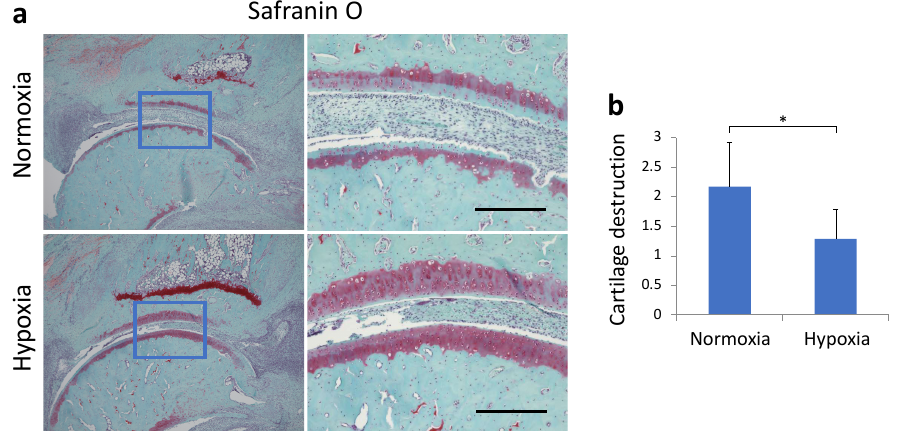
Figure 5. ( a ) Representative micrographs of safranin-O-stained sagittal sections of ankle joint. ( b ) The cartilage evaluation scores based on the histological score (mean ± standard deviation) are shown. Each value represents the mean ± SD (n = 5); * p < 0.05. Scale bar = 200 μm.